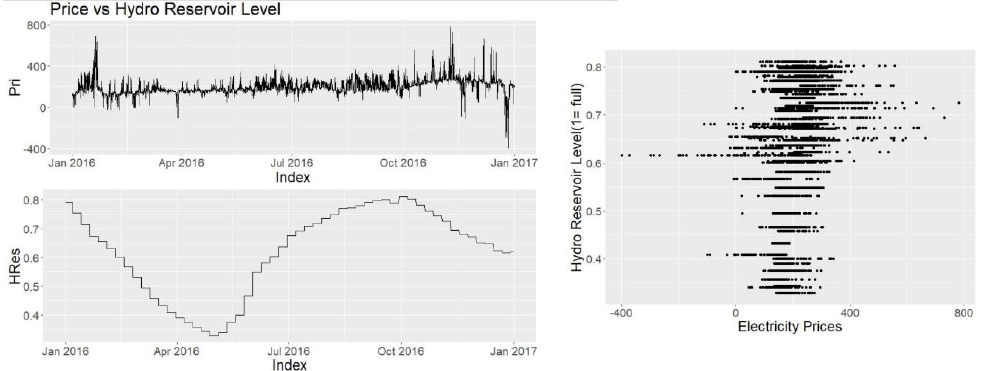
Figure 14. Price vs. Hydro reservoir level.